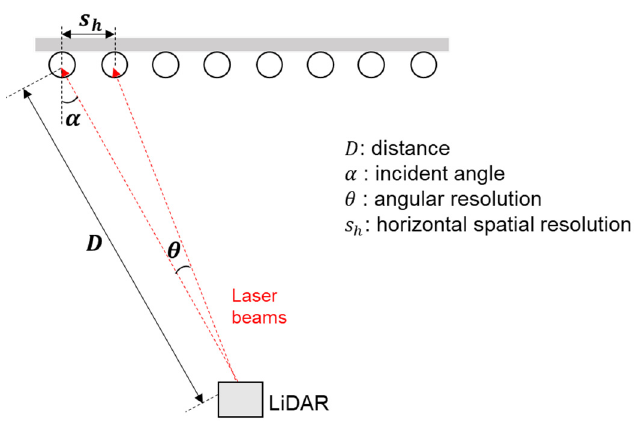
Figure 12. Relationships between scanning parameters and scanned data quality.